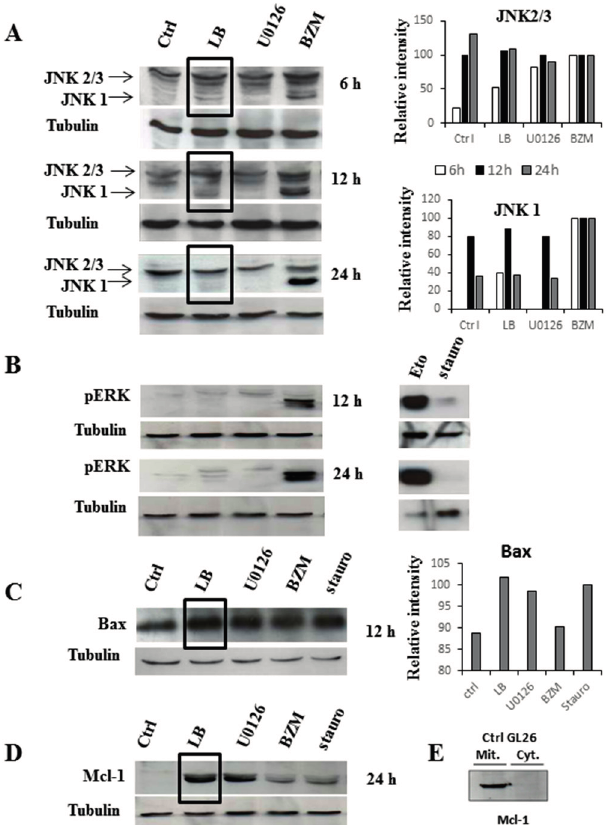
Figure 2. Western Blotting analysis reveals the molecular signaling activated on glioblastoma cells by LB treatment. GL26 cells were treated as described in M & M and lysate at different time points. Proteins (50 µg/lane) were separated in SDS-polyacrylamide gels and transferred to nitrocellulose membranes before incubation with antibodies anti-JNKs, pERK, Bax and Mcl-1. Tubulin antibody was used as internal control for loading. Ctrl: untreated cells; LB: Bak Liposomes; BZM: Bortezomib; Eto: Etoposide; Stauro: Staurosporine. Panels ( A – C ): total proteins; panel ( D ): cytoplasmic fraction; and panel ( E ): mitochondrial fraction. Histograms represent the band intensity values; BZM and Stauro treatments are considered as protein-induction positive controls for JNKs and Bax proteins, respectively. Bands